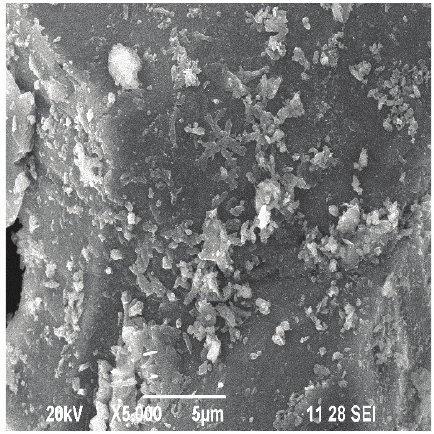
Figure 4: SEM of specific surface of WSD dust